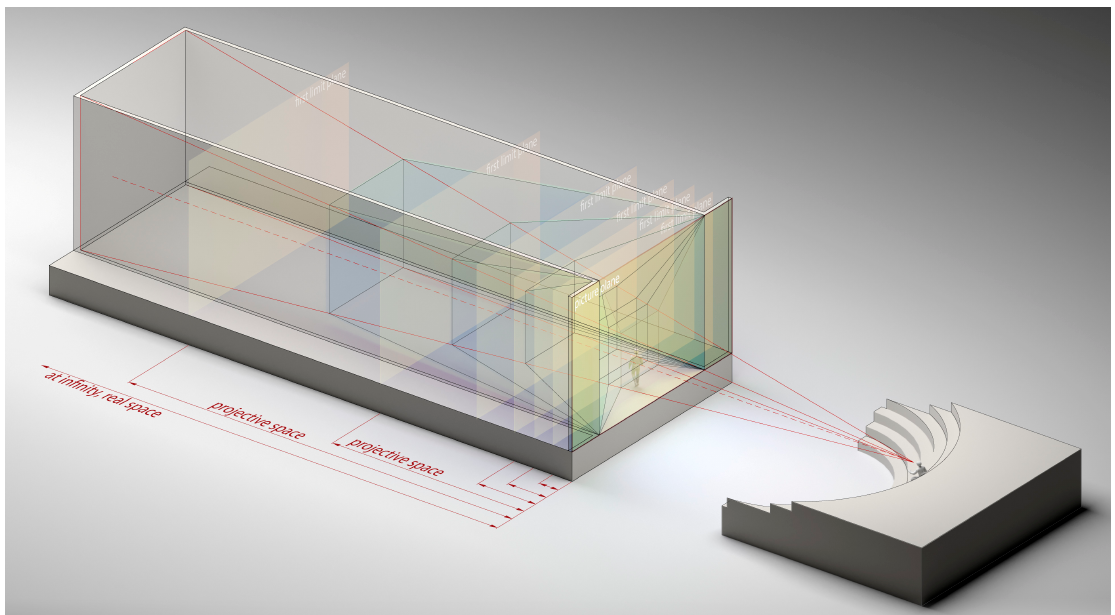
Figure 1. Perspective transformation of solid space in a Renaissance theatre